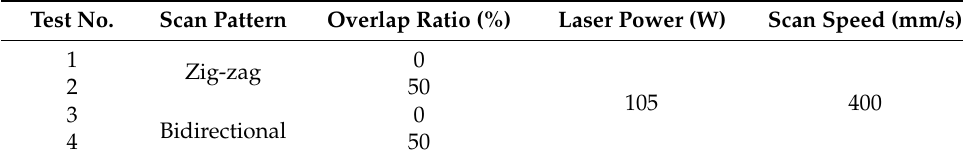
Table 2. Process conditions used in the simulation. Test